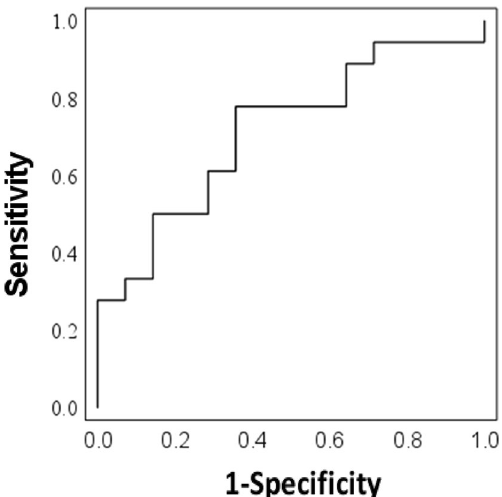
Figure 5. ROC curves of anti-HSP47 antibody for differentiating CD with or without intestinal stricturing. ROC curve of anti-HSP47 antibody showing an AUC of 0.714. HSP heat shock protein, CD Crohn’s disease, UC ulcerative colitis, ROC receiver operating characteristics, AUC area under the curve.